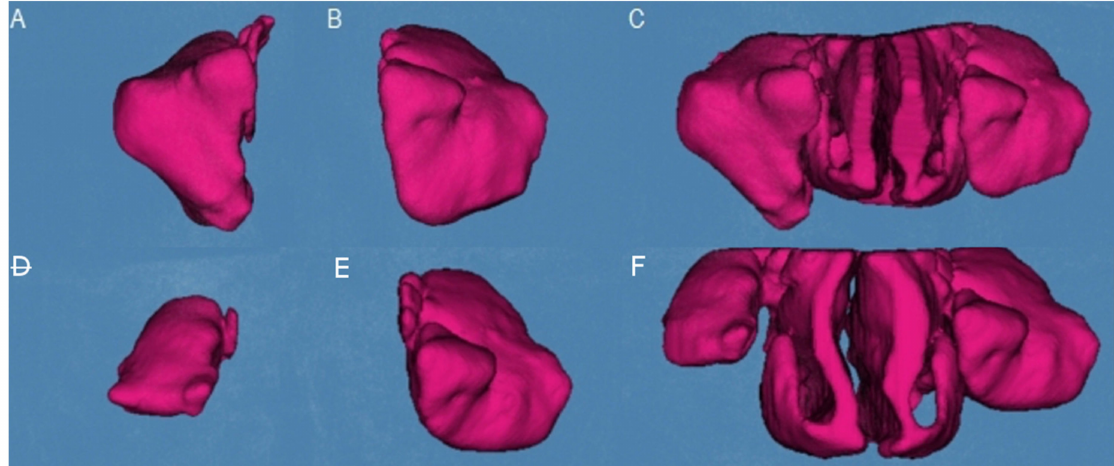
Figure 3. ( A ) Preoperative volumetric assessment of the right maxillary sinus, ( B ) left maxillary sinus, and ( C ) nasal and maxillary sinus airway complex. ( D ) Postoperative volumetric assessment of the right maxillary sinus, ( E ) left maxillary sinus, and ( F ) nasal and maxillary sinus airway complex.